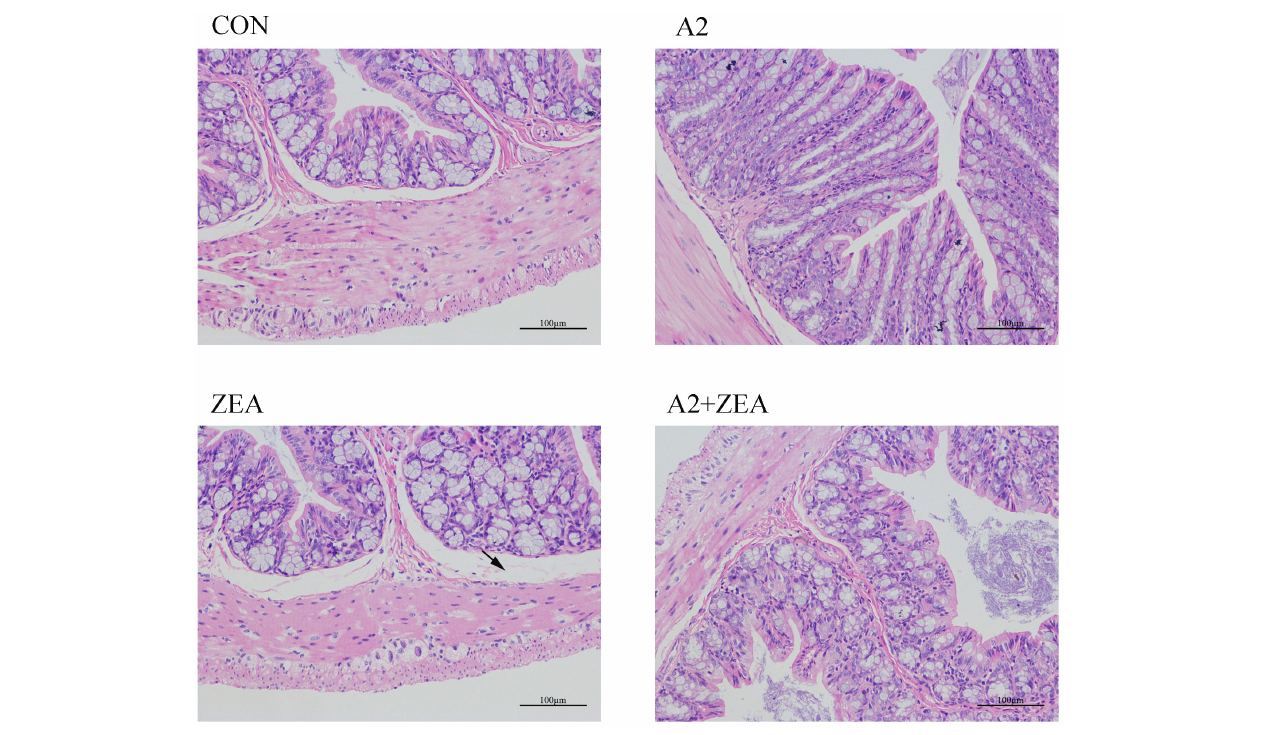
FIGURE 1 | H & E image of cecal tissue